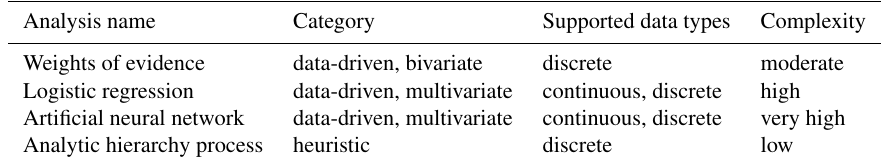
Table 1. Analyses included in LSAT PM and their